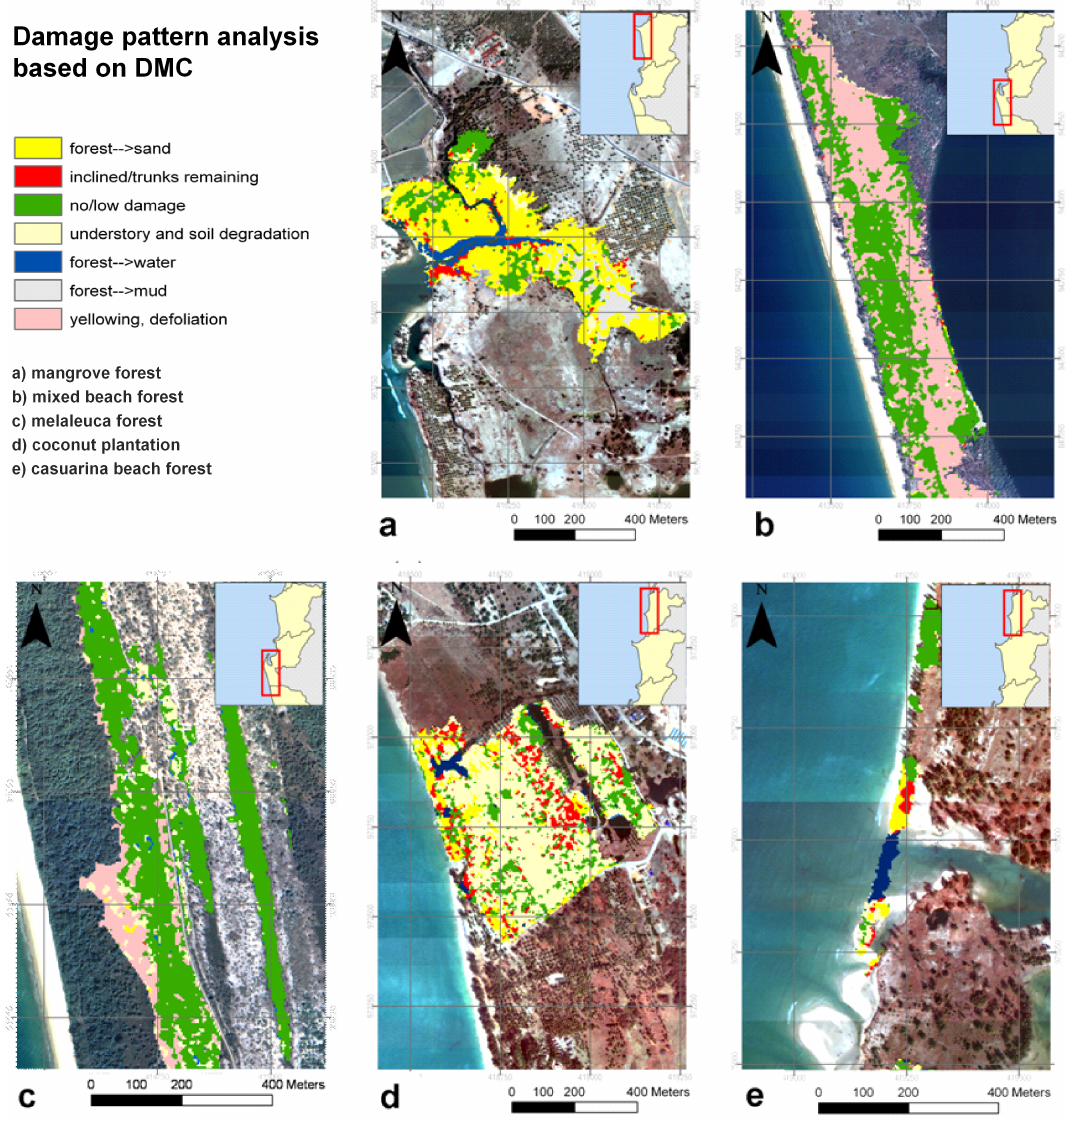
Fig. 9. Change maps based on DMC, illustrated for the five coastal forests in the Phang-Nga province.